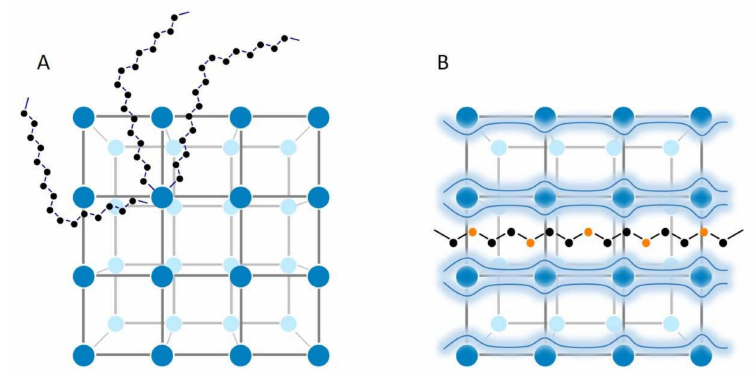
Figure 1. ( A ) Metal–organic frameworks (MOFs) as catalysts for polymerization. ( B ) MOFs as templates for